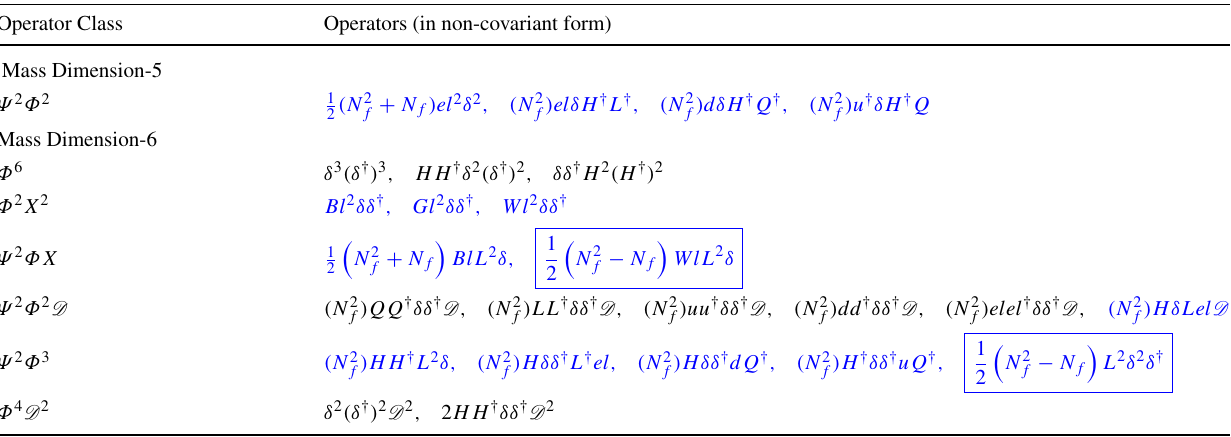
Table 31 SM + singly charged scalar( δ + ): Operators of mass dimensions-5 and -6 excluding pure SM operators. The operators in blue have distinct hermitian conjugates which we have not written explicitly. Boxed operators vanish for N f = 1. Here, δ → δ + and δ † → δ − Operator Class